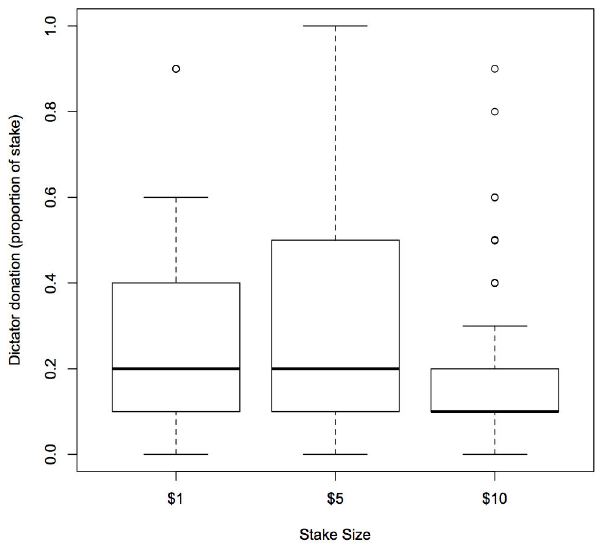
Figure 2. Boxplot of dictator donations (proportion of endowment given to receiver) according to stake size for Indian players. Solid lines represent medians while the upper and lower boundaries of the box are the upper and lower quartiles of the data. The highest and lowest values in the data (excluding outliers) are indicated by the bars extending from the boxes. Circles represent outliers.